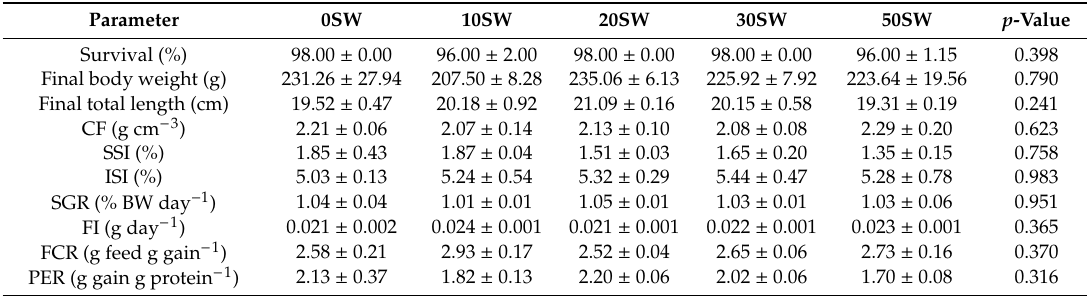
Table 4. Survival, growth performance and feed utilization of sex-reversed Nile tilapia fed experimental diets containing various levels of FM protein replaced with